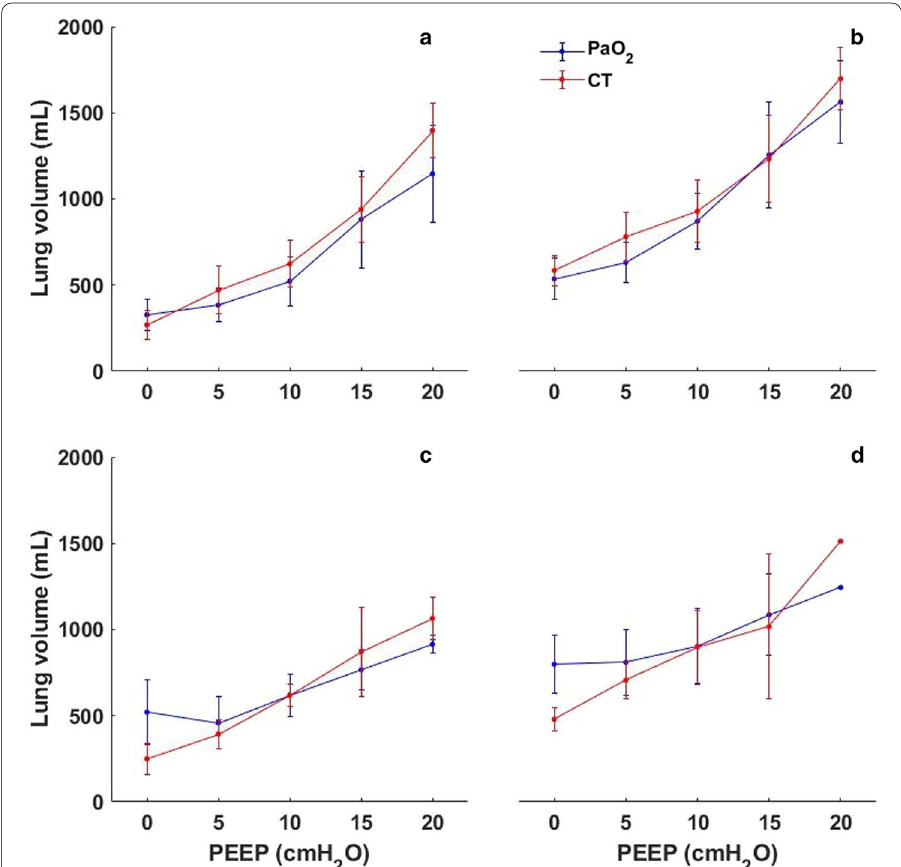
Fig. 3 Lung volume measurement (mean SD) from PaO 2 analysis and CT imaging at different PEEP levels ± during incremental PEEP titration. V PaO2 and V CT measurements in the control animals during a apnoea at end-expiration and b end-inspiration. V PaO2 and V CT measurements in the saline lavage lung injury model during c apnoea at end-expiration and d end-inspiration. Additional file 1: Table S2 provides full details of volumes measured and probabilities of